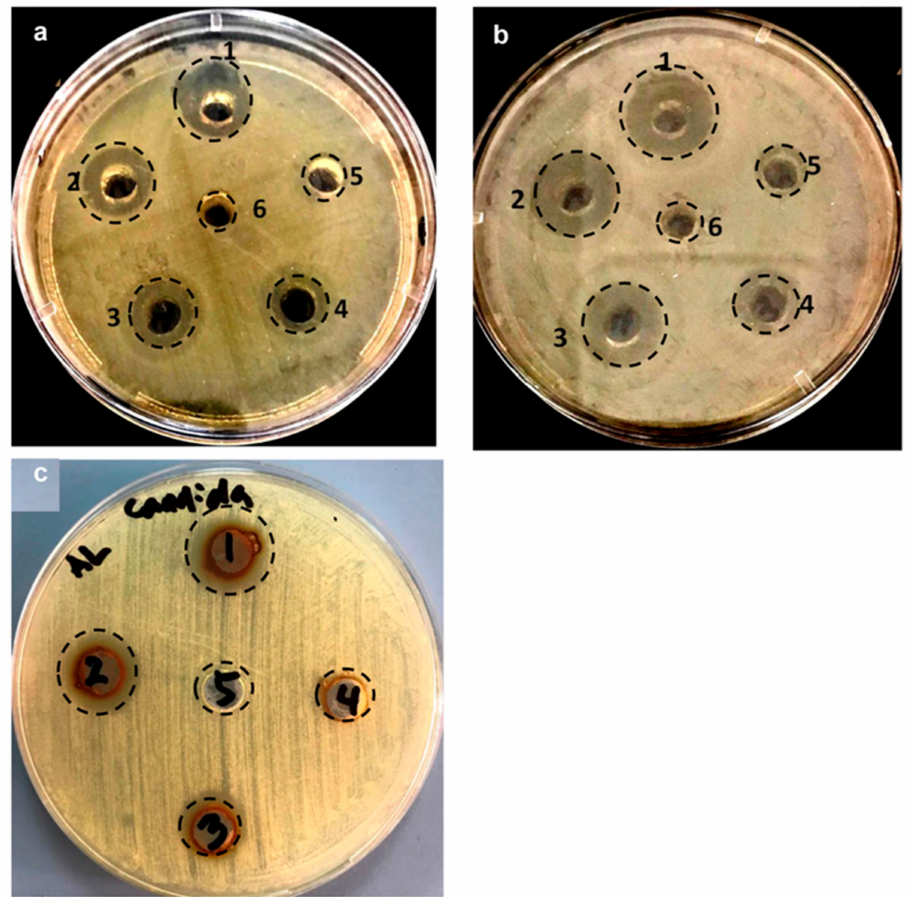
Figure 7. Assessment of antimicrobial activity of PLE alone and LIV-AgNPs by well diffusion assay. Comparative antimicrobial effects induced by, 100 µ L of pristine PLE (well 6) as control and increasing amounts i.e., (well 5) 12.5, (well 4) 25, (well 3) 50, (well 2) 100 and (well 1) 200 µ g/mL of LIV-AgNPs against the Gram-negative multiple drugs resistance Pseudomonas aeruginosa (MDR-PA) (panel-( a )) and Gram-positive methicillin-resistant Staphylococcus aureus (MRSA) (panel-( b )). Panel-( c ) showing zone of inhibition of C. albicans where well (5) represent control i.e., 100 µ L of pristine PLE, well (4) filled with 25, well (3) 50, (well 2) 100 and (well 1) 200 µ g/mL of LIV-AgNPs,